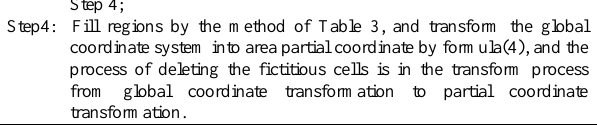
Table 9. Generation algorithm of the area entity of the